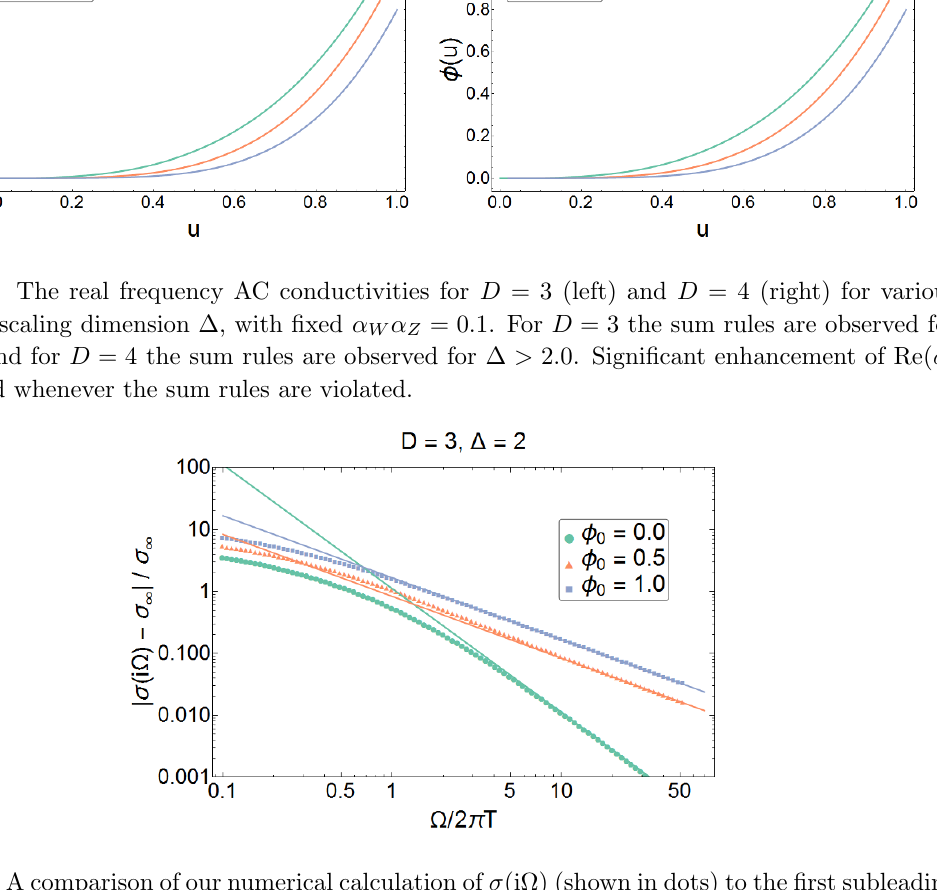
Figure 7 . A comparison of our numerical calculation of (cid:27) (i(cid:10)) (shown in dots) to the (cid:12)rst subleading contribution in the asymptotic expansion (1.3) (shown as thin solid line), when (cid:10) T . We take (cid:29) (cid:1) = 2 and D = 3. As predicted in (1.3), when h = 0 the (cid:12)rst subleading power (cid:10) (cid:0) (cid:1) is smaller than when h = 0. For h = 0, the asymptotic corrections are proportional to h and governed by the 6 6 same power (cid:10) (cid:1) (cid:0) D , leading to a slower decay. ((cid:8) 0 = 0) the high-frequency conductivity is proportional to (cid:10) D (cid:0) 3 (cid:0) (cid:1) , while when the scalar is tuned away from the critical point ((cid:8) 0 = 0) the high-frequency conductivity is 6 proportional to (cid:10) (cid:1) (cid:0) 3